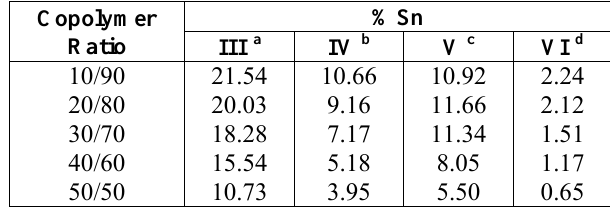
Table 2. The experimental tin percentages of copolymers III–VI with different